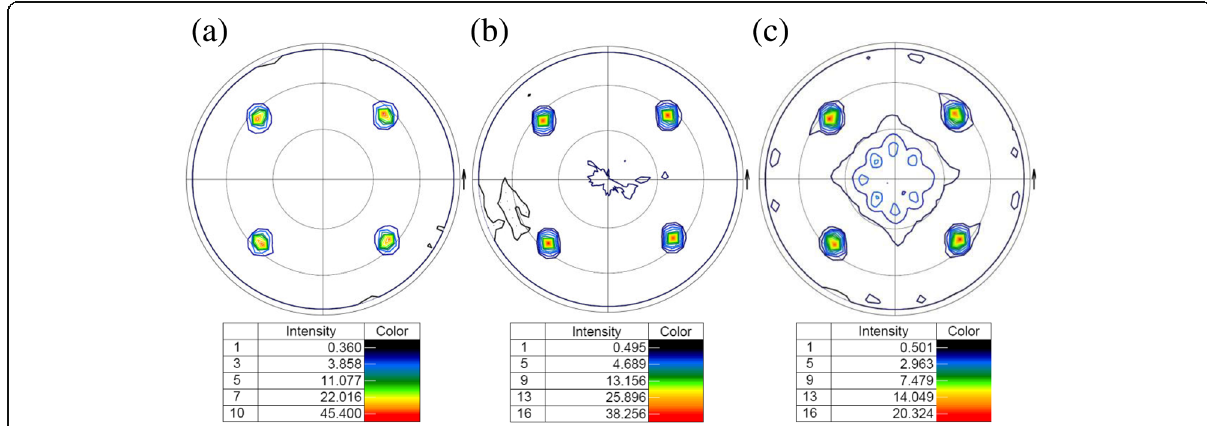
Fig. 4 X-ray (111) pole figure in root scale of STO films deposited at laser frequency and chamber pressure of 10 Hz and 10 − 4 mbar, respectively, on Cu-clad substrate at temperatures of a 500 °C, b 550 °C, and c 600